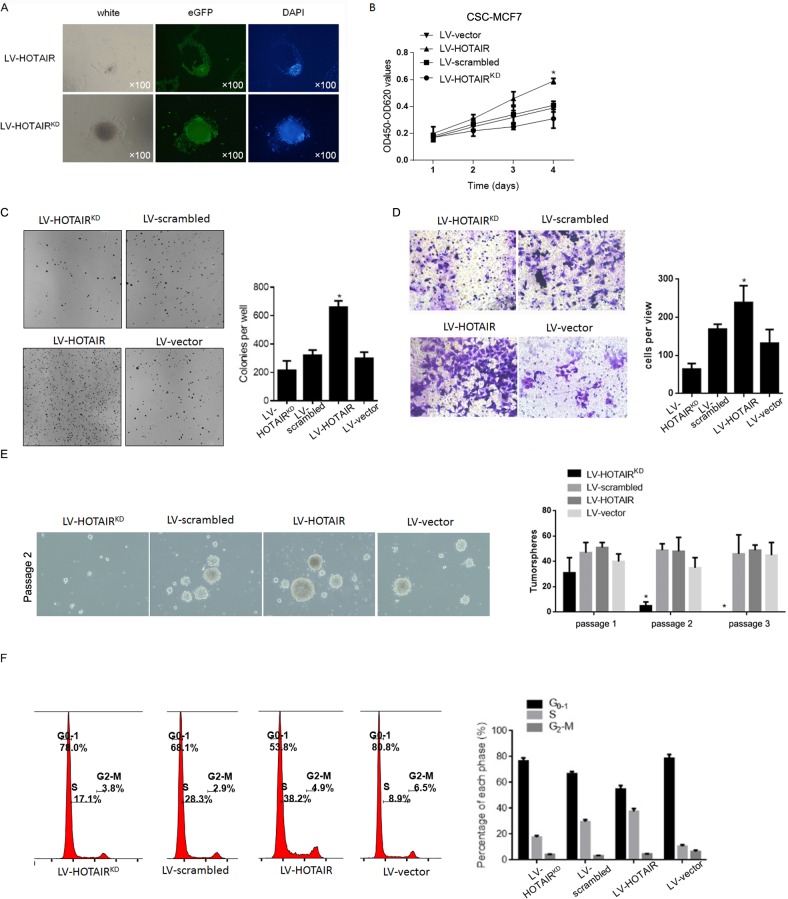
Expression of HOTAIR in CSC-MCF7 regulates proliferation, colony formation, migration and self-renewal capacity.(A) Detection of eGFP confirmed the successful infection of LV-HOTAIR or LV-HOTAIRKD. (B) A CCK-8 assay was performed to detect proliferation in MCF7 cells transfected with LV-HOTAIR, LV-scrambled or LV-HOTAIRKD. (C) A colony formation assay was performed in MCF7 cells transfected with LV-HOTAIR, LV-scrambled or LV-HOTAIRKD (Left panel); the colonies in each well were counted after nitro blue tetrazolium (NBT) staining (Right panel). (D) A migration assay was performed in uncoated transwell chambers (Left panel); the cells that migrated through the membrane were stained with 0.05% crystal violet and counted (Right panel). (E) Self-renewal capacity was detected in serum-free medium; spheres (>40 μm in diameter) were counted per well at different passages. *P<0.05.